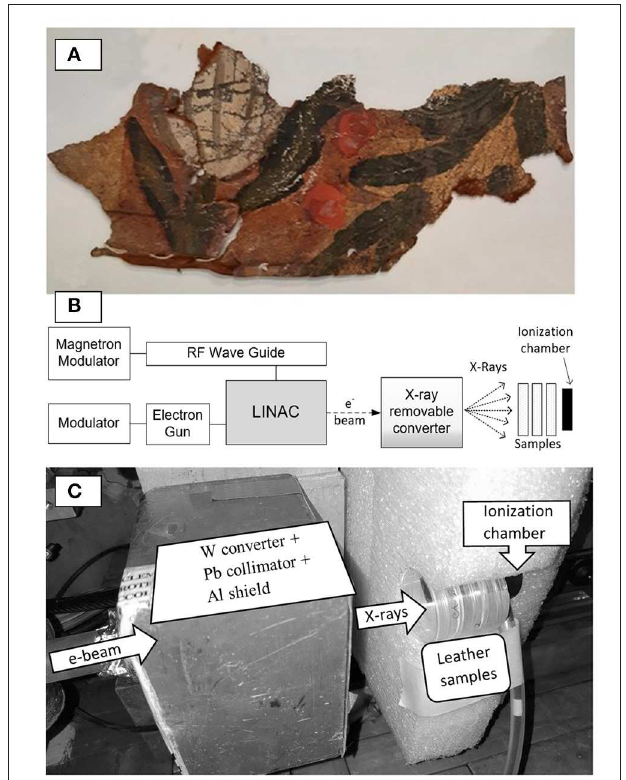
FIGURE 1 | Leather specimens coming from Chigi Palace, Ariccia (Italy) and REX Irradiation System. (A) Fragment of ancient Spanish leather; (B) scheme of the REX facility and the irradiation geometrical layout set for experimental campaigns of leather treatment; (C) View of the irradiation layout inside the treatment chamber of the REX